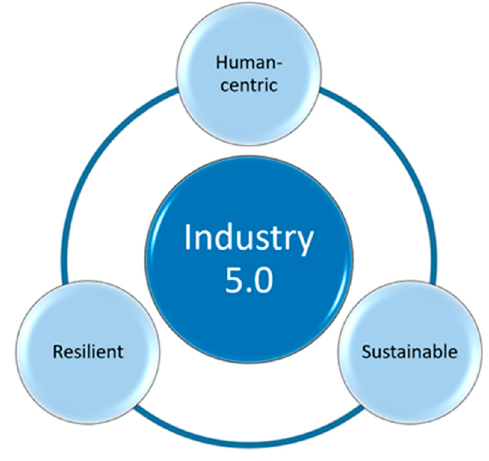
Figure 2. Industry 5.0 with three key